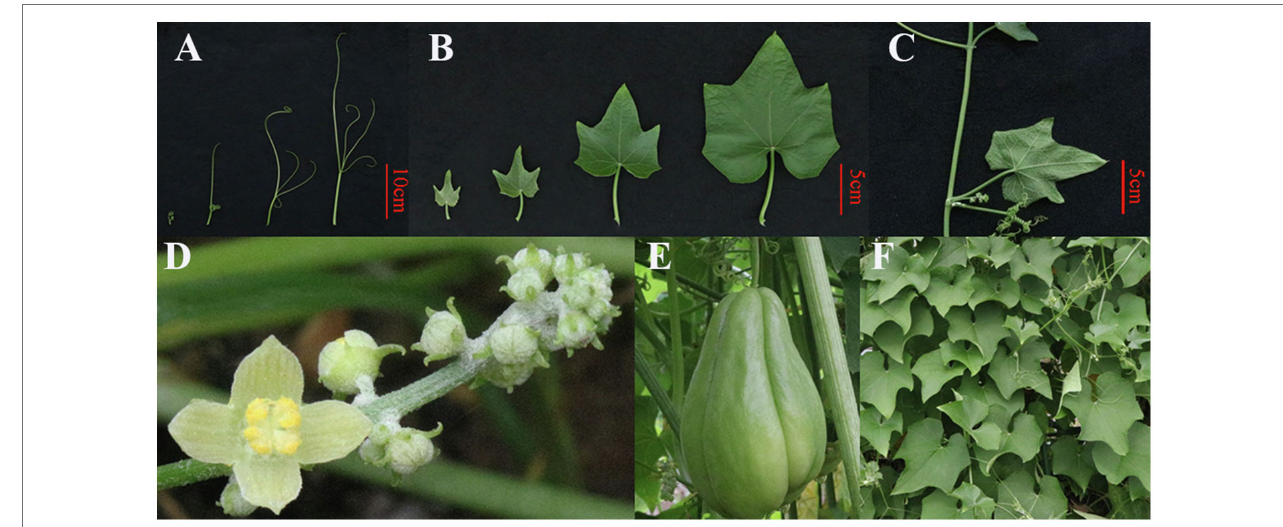
FIGURE 1 | The whiskers (A) , leaves (B) , stem (C) , flowers (D) , fruit (E), and plants (F) of the Sechium